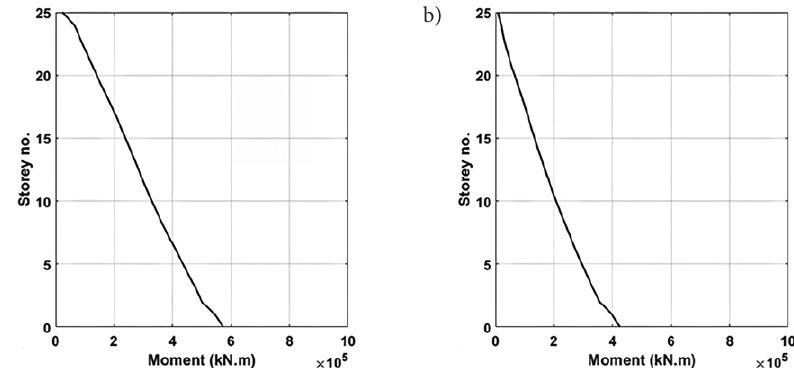
Figure 14. Peak story moment curves vs. story number under RS analysis in the: a – transverse direction and b –